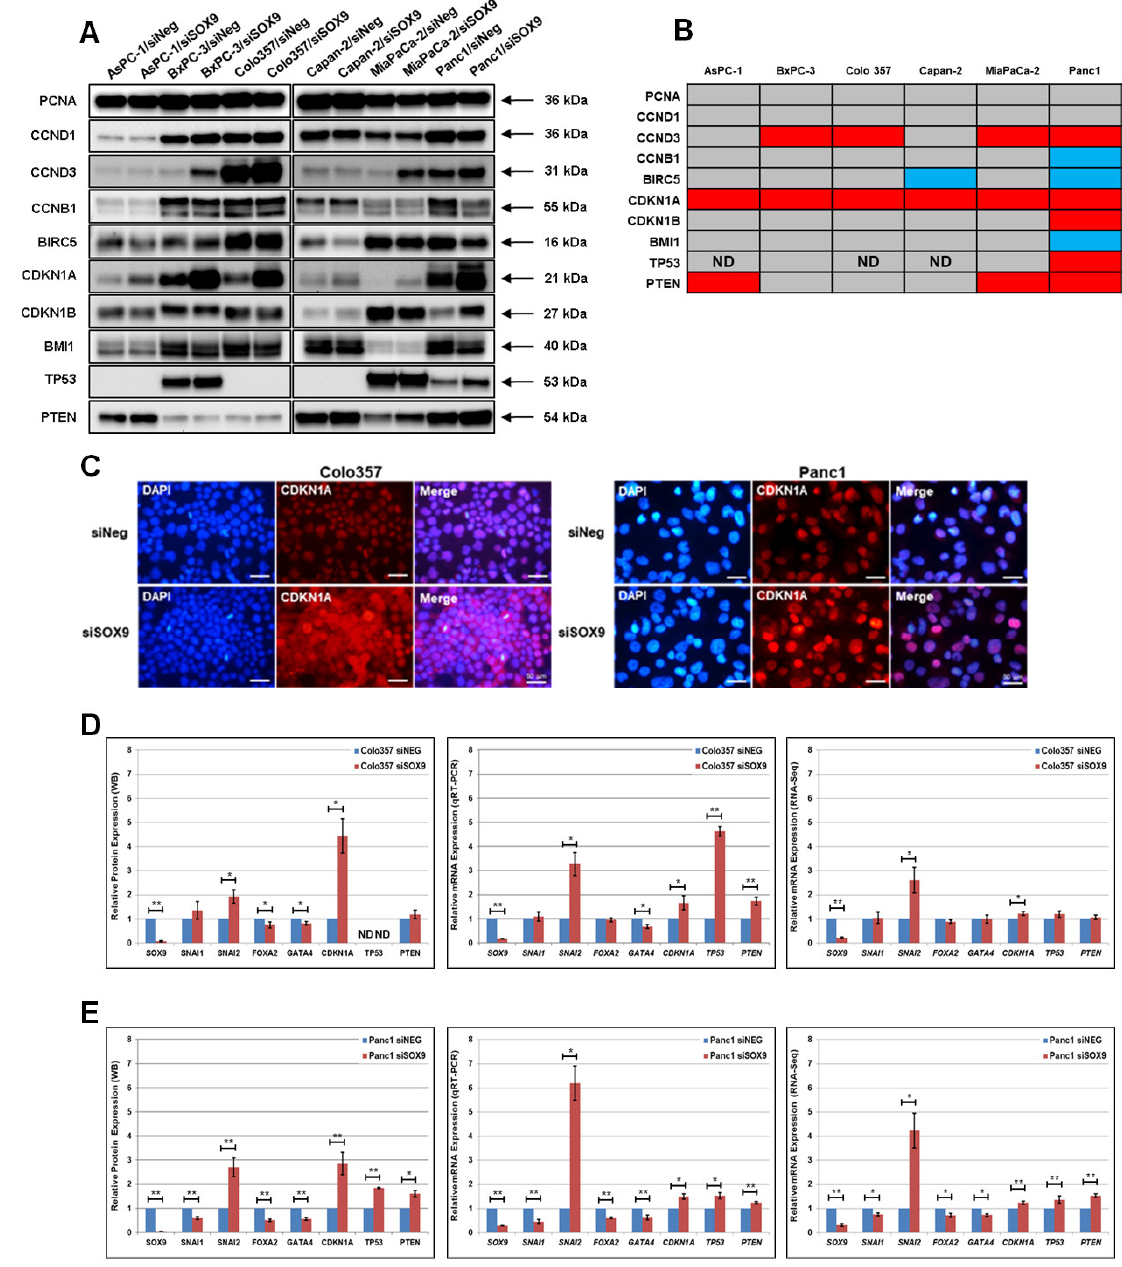
Figure 3. The effect of SOX9 downregulation on the expression levels of cell cycle protein regulators. ( A ) Western blot analysis of the expression of cell cycle protein regulators in the investigated cell lines transfected with control siNeg and siSOX9 ( n = 3). ( B ) Heatmap of differentially expressed cell cycle protein regulators from ( B ). Color code: red, upregulation; blue, downregulation; gray, no change. ND = undetected expression. ( C ) Immunofluorescence imaging of p21 Waf1/Cip1 (CDKN1A) expression in Colo357 and Panc1 cells transfected with control siNeg and siSOX9. Cells were stained for SOX9 (red). Nuclei were stained with DAPI (blue). Scale bar = 50 µm. ( D , E ) Relative Western blot, RT-qPCR, and RNA-Seq data quantification of the levels of SOX9, SNAI1, SNAI2, FOXA2, GATA4, CDKN1A, TP53, and PTEN in control siNeg and siSOX9 transfected Colo357 ( D ) and Panc1 ( E ) cells. RT-qPCR and RNA-Seq data are means ± SEM from three technical replicates and representative of at least three experiments. * p ≤ 0.05; ** p ≤ 0.01 compared with siNeg control.